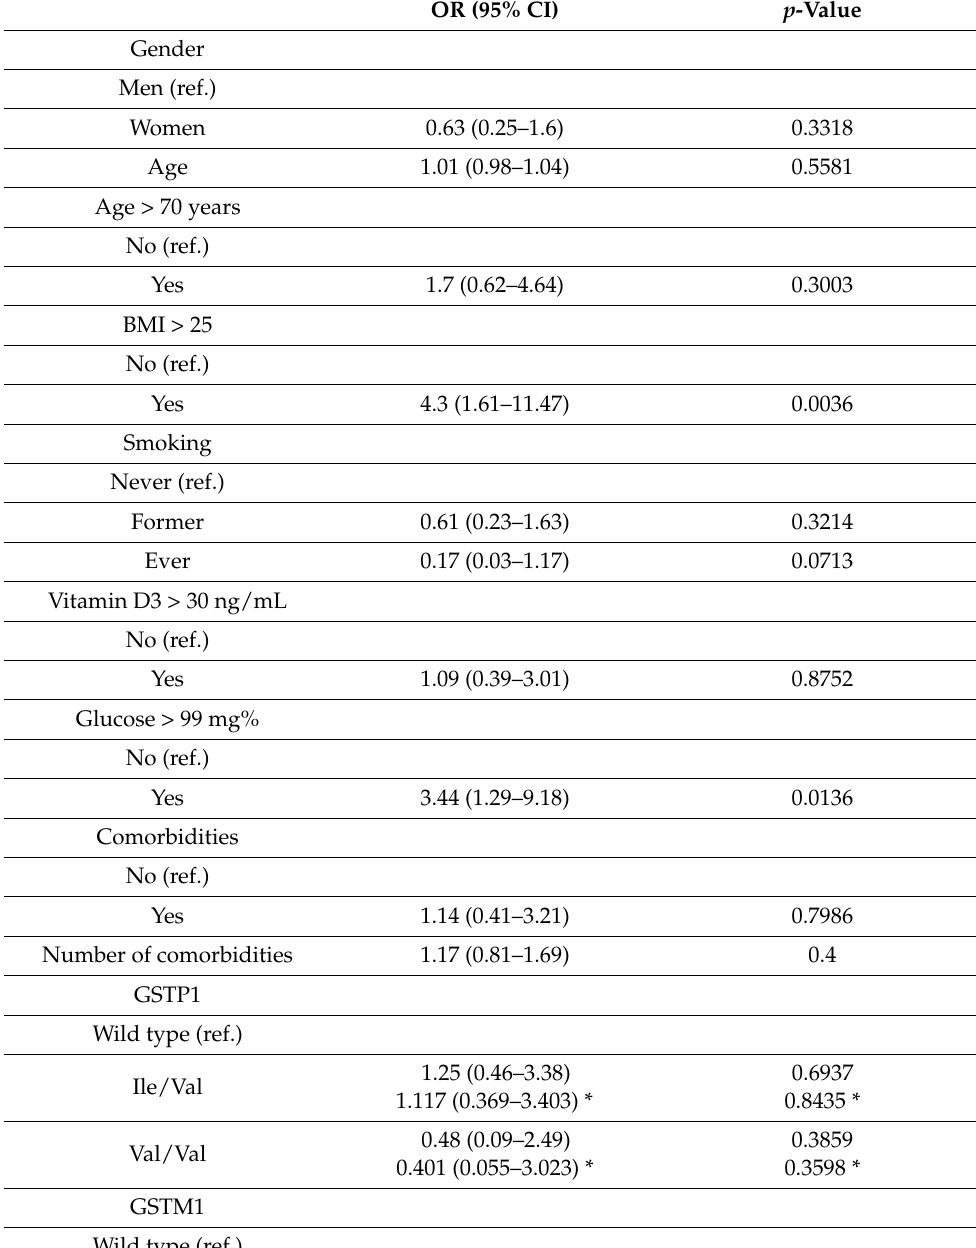
Table 2. Logistic regression analysis of the risk factors of mild to severe COVID-19 in unvaccinated individuals developing